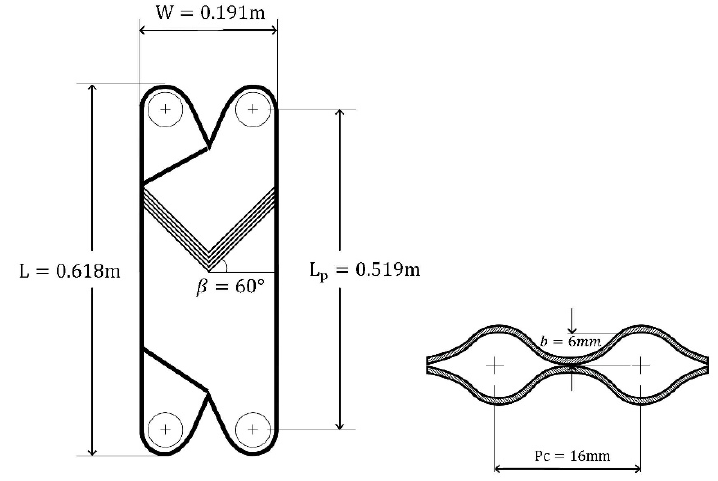
Figure 3. The plate evaporator positioning in the system. Source: own elaboration.